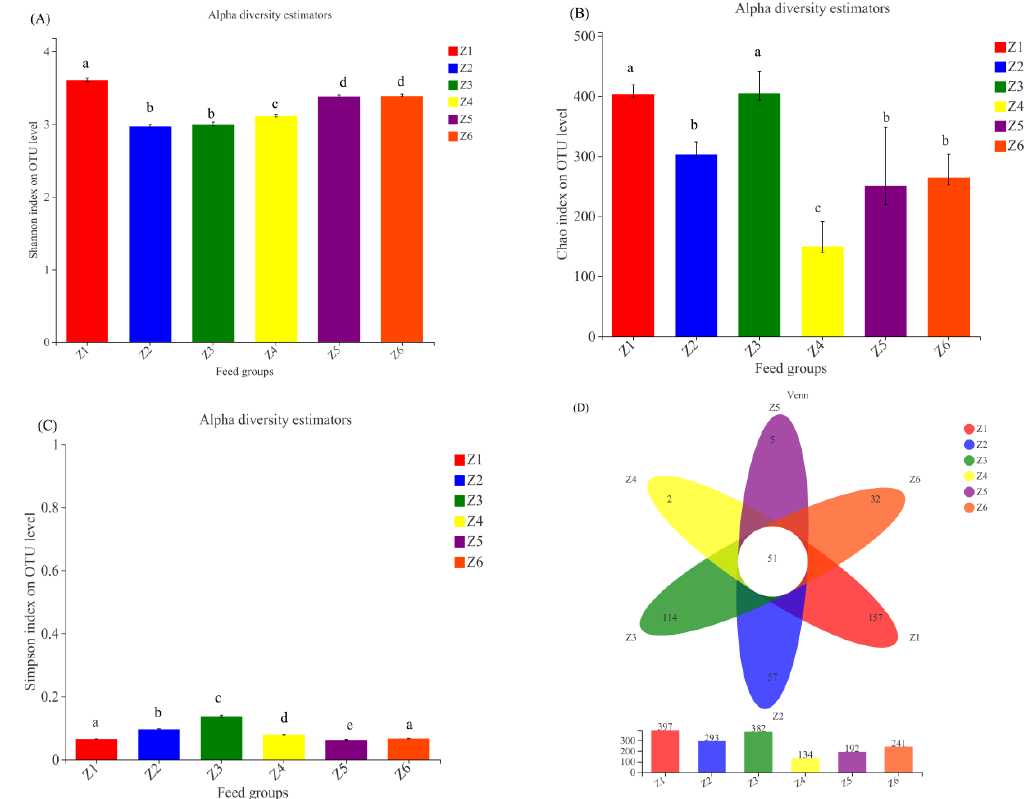
Figure 3. Alpha diversity ( A ): Shannon index, ( B ): Chao1 index, ( C ): Simpson index), and Venn diagram of the obtained OTUs ( D ). Different characters indicate a significant difference ( p < 0.05). Z1, Z2, Z3, Z4, Z5, and Z6 represent the 6 experimental groups of 0, 50, 100, 200, 300, and 400 mg/L mixed flocculant, respectively.